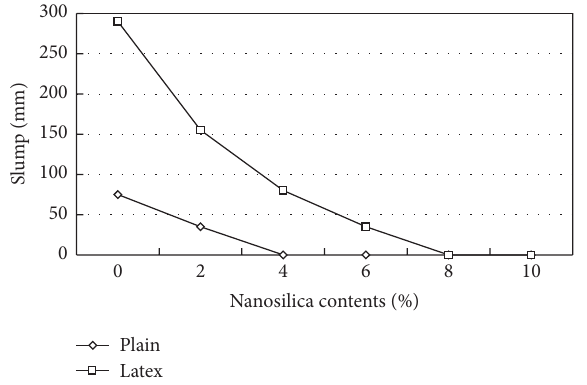
Figure 2: Slump value of PCC and LCC with nanosilica contents.